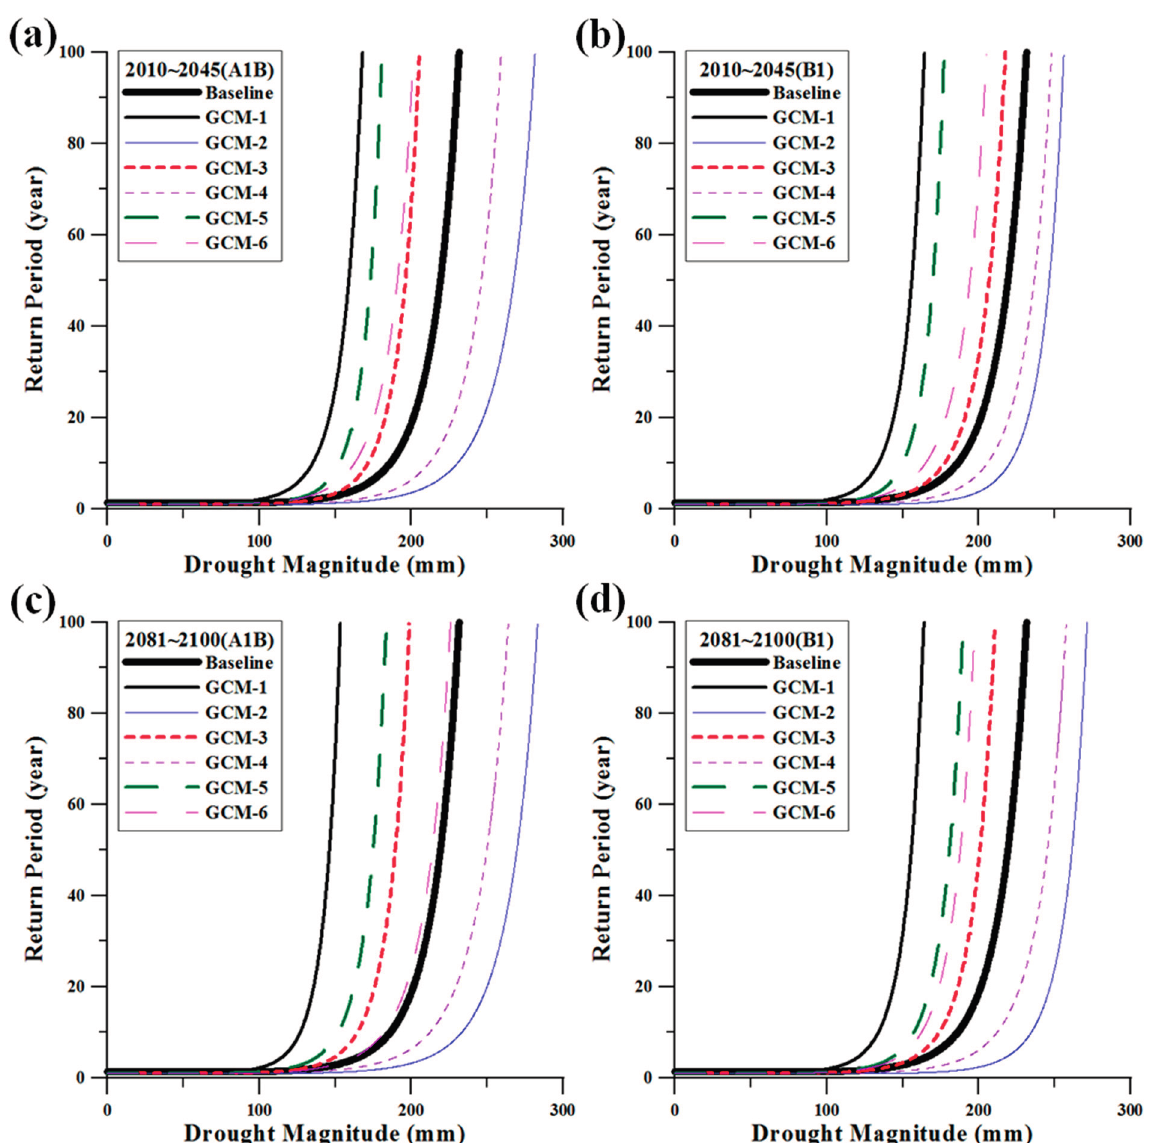
Figure 11. The probability distributions of drought magnitude for different